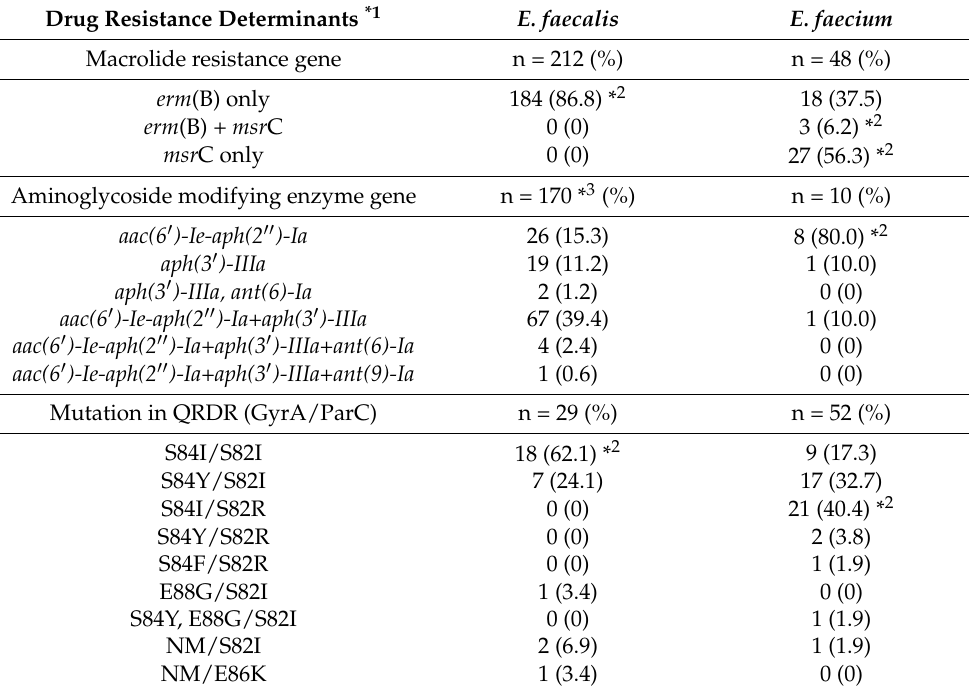
Table 3. Profiles of antimicrobial resistance determinants in E. faecalis and E. faecium showing resistance to erythromycin, gentamicin, and